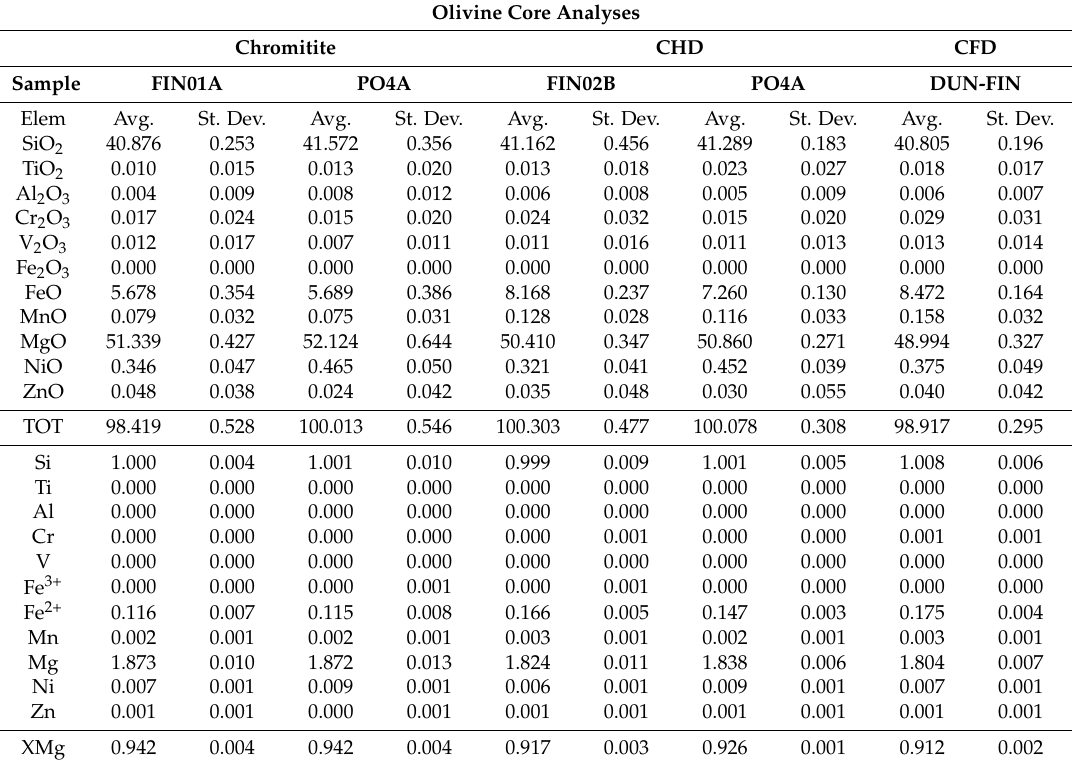
Table 2. Major and trace elements average content and standard deviation of olivine cores from Rio Creves and Alpe Polunia, for the three host rocks: chromitite, CHD,